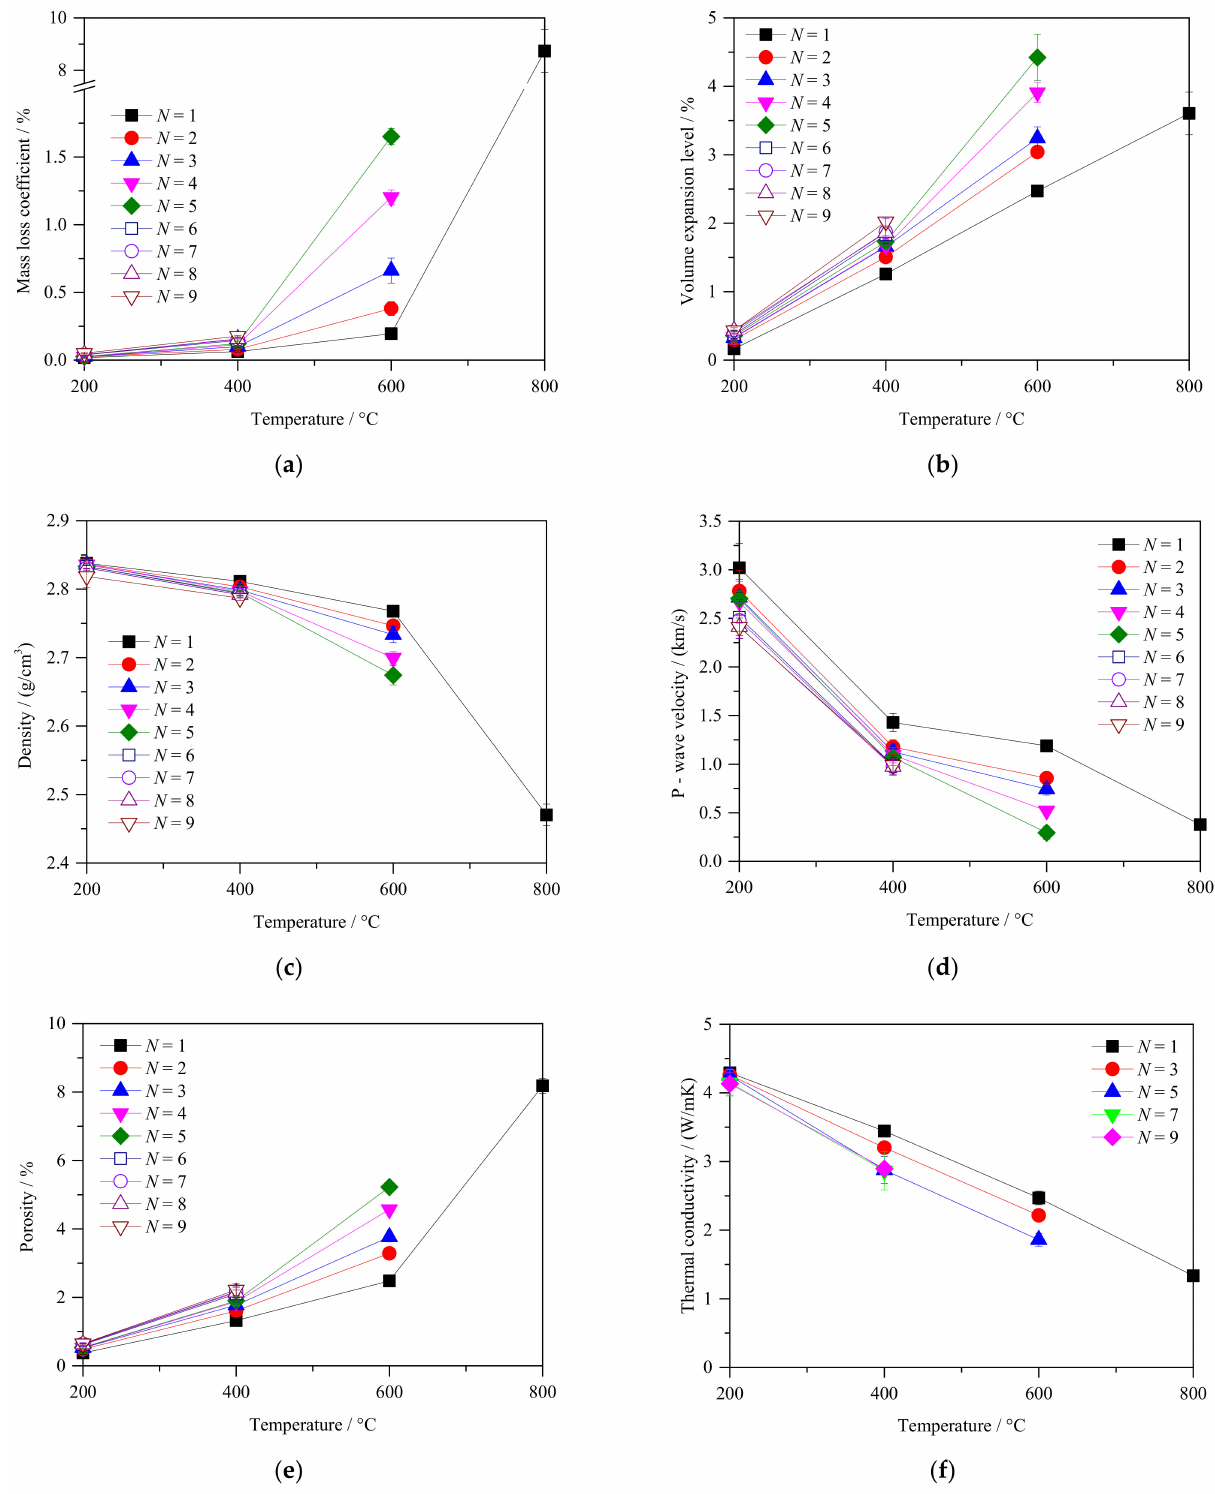
Figure 7. Effect of temperature levels on the ( a ) mass loss coefficient, ( b ) volume expansion level, ( c ) density, ( d ) P-wave velocity, ( e ) porosity and ( f ) thermal conductivity (The error bar represents the standard